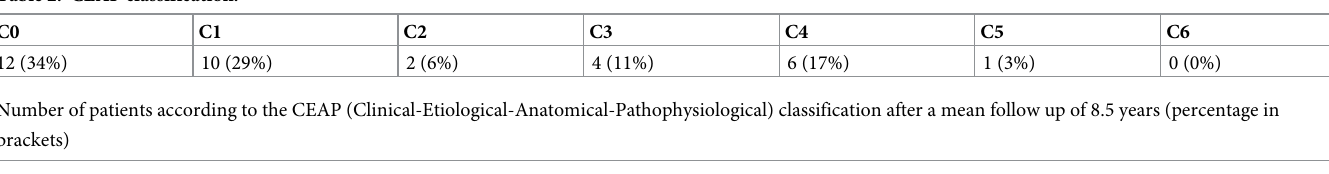
https://doi.org/10.1371/journal.pone.0235003.t002